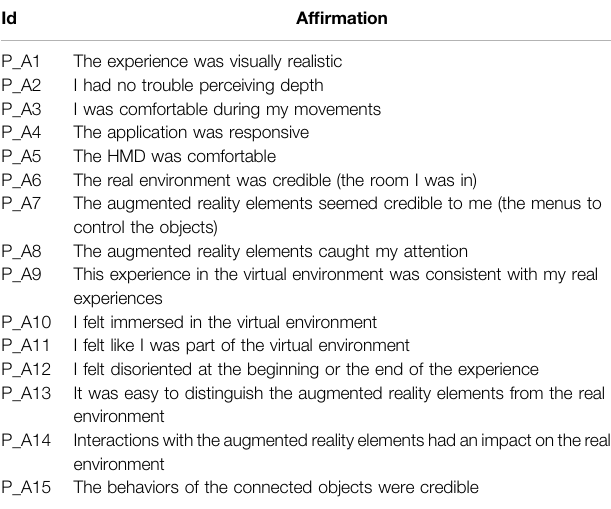
TABLE 2 | The fi fteen statements we used to measure the proximity between the different conditions.